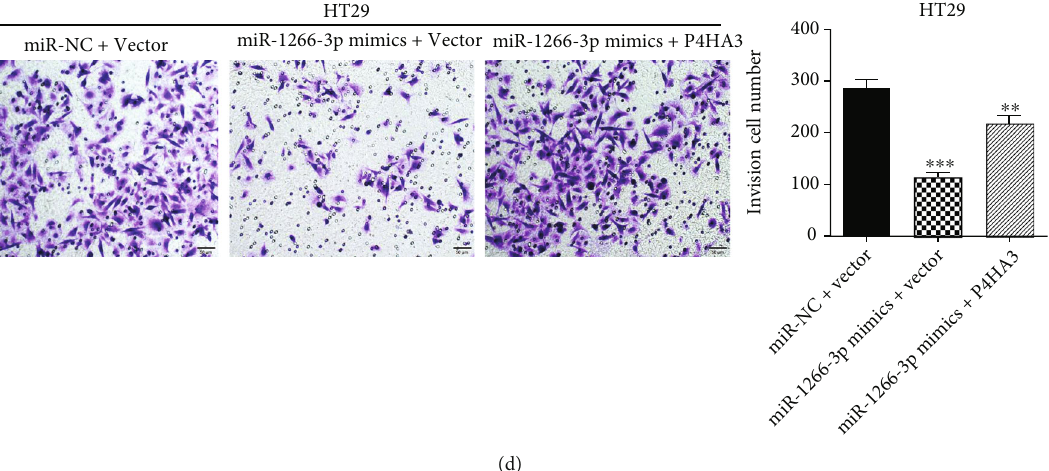
Figure 4: P4HA3 reversed the miR-1266-3p mediated ability of inhibiting cell migration and invasion in colon cancer cells. (a – b) The reversal e ff ects of P4HA3 overexpression on miR-1266-3p-mediated migratory capacity of SW480 and HT29 cells was be veri fi ed by wound-healing assay ( ∗∗ P < 0 : 01 ). (c – d) Tranwell assay revealed the reversal e ff ects of P4HA3 overexpression on miR-1266-3p-mediated invasive capacity of SW480 and HT29 cells ( ∗∗ P < 0 : 01 , ∗∗∗ P < 0 : 001